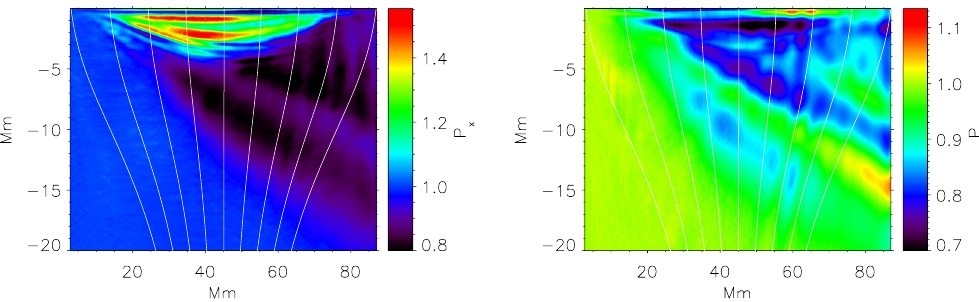
Fig. 3. Horizontal (left panel) and vertical (right panel) acoustic power ratios between the quiet and magnetic parts of the synthetic data obtained by means of forward modelling. The magnetic field lines are overplotted. Strong absorption is observed in the vertical acoustic power in the magnetised region, while the horizontal power component shows a strong enhancement. Note that the scaling is different in vertical and horizontal directions is different, thus the magnetic field lines in the plots do not show the actual inclination of the magnetic field in the